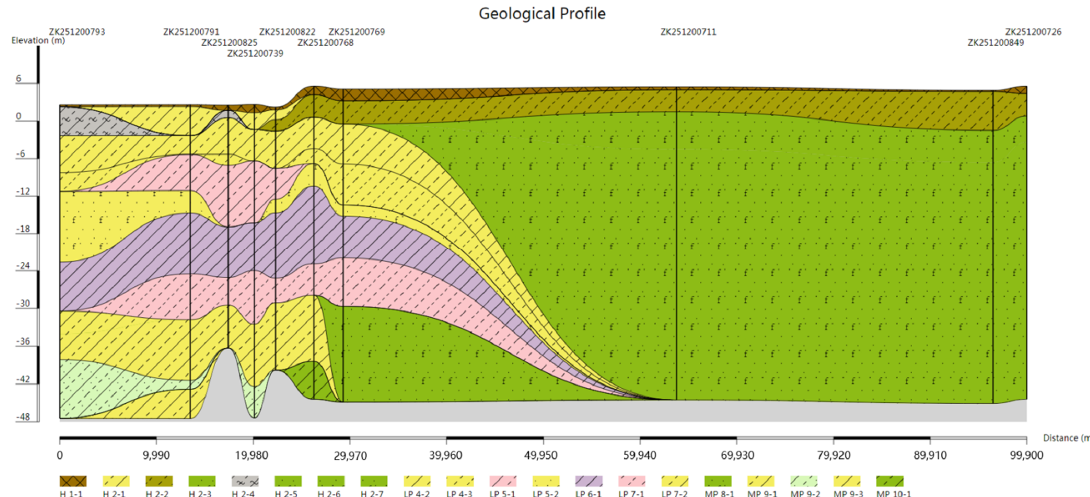
Figure 17. Typical geological profile of Lihe Plain and Yangtze River Delta floodplain by unique path method. In the Figure 18b,c, four geological transects are generated from the 3D geological model of this area. Compared to that of previous geological profiles (Figure 8 through